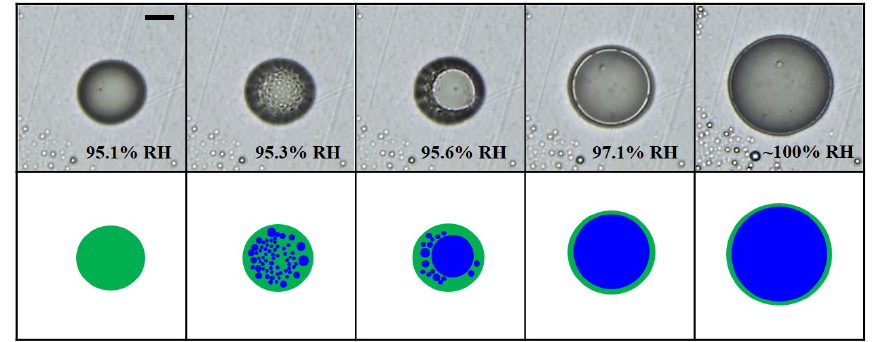
Figure 3. Optical images of a SOA particle produced from α -pinene ozonolysis with NH 3 ( α -pinene O 3 / NH 3 no. 1 in Table 2) with increasing RH. The purpose of the illustrations is to clarify the images. Green is the SOA-rich phase, and blue is the water-rich phase. The scale bar is 20µm.